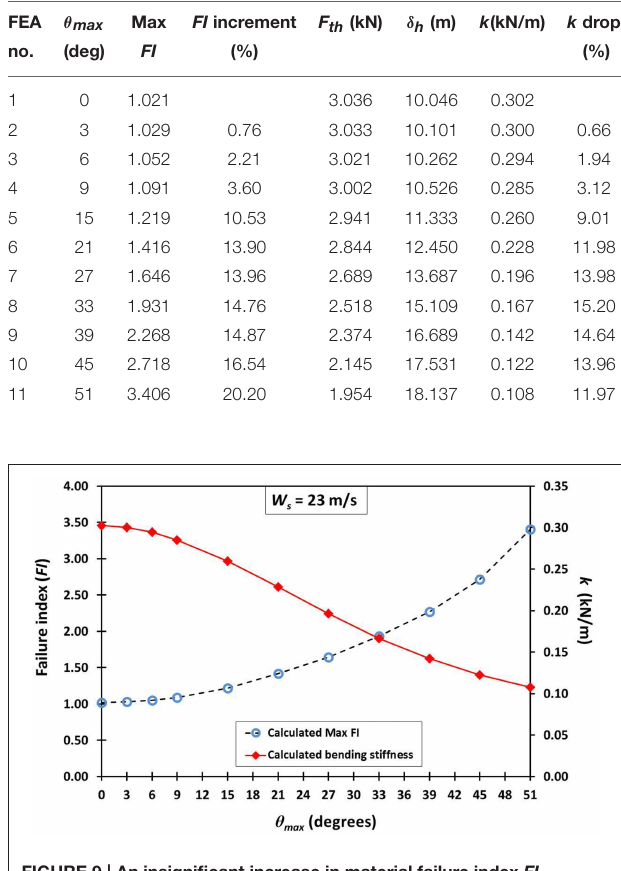
FIGURE 9 | An insignificant increase in material failure index FI (segmented line with blue circles) is observed for fibrovascular bundle degrees of orientation up to 9 ◦ . Beyond this point, the slope of the FI curve starts to drastically increase reaching a FI of about 3.5 when the angle varied to 51 ◦ . For the θ max of 15 ◦ , there is a sudden FI increment that is three times higher than the previous value at 9 ◦ . Similarly, the palm bending stiffness k (red line with rhombi) is sharply reduced by nearly three times from 9 ◦ to 15 ◦ . The identified trends become higher and lower, respectively, for the greater values of θ max